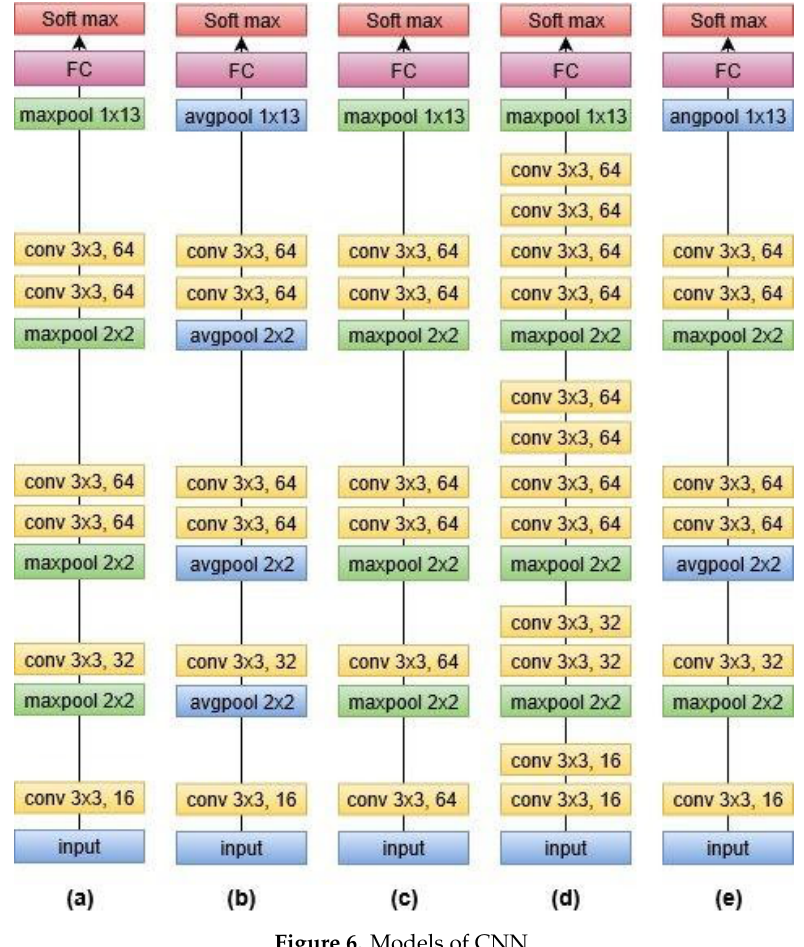
Figure 6. Models of CNN.